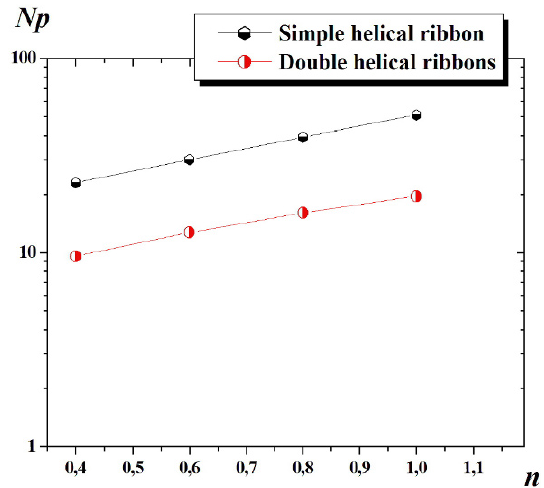
Figure 20. Power number for Re